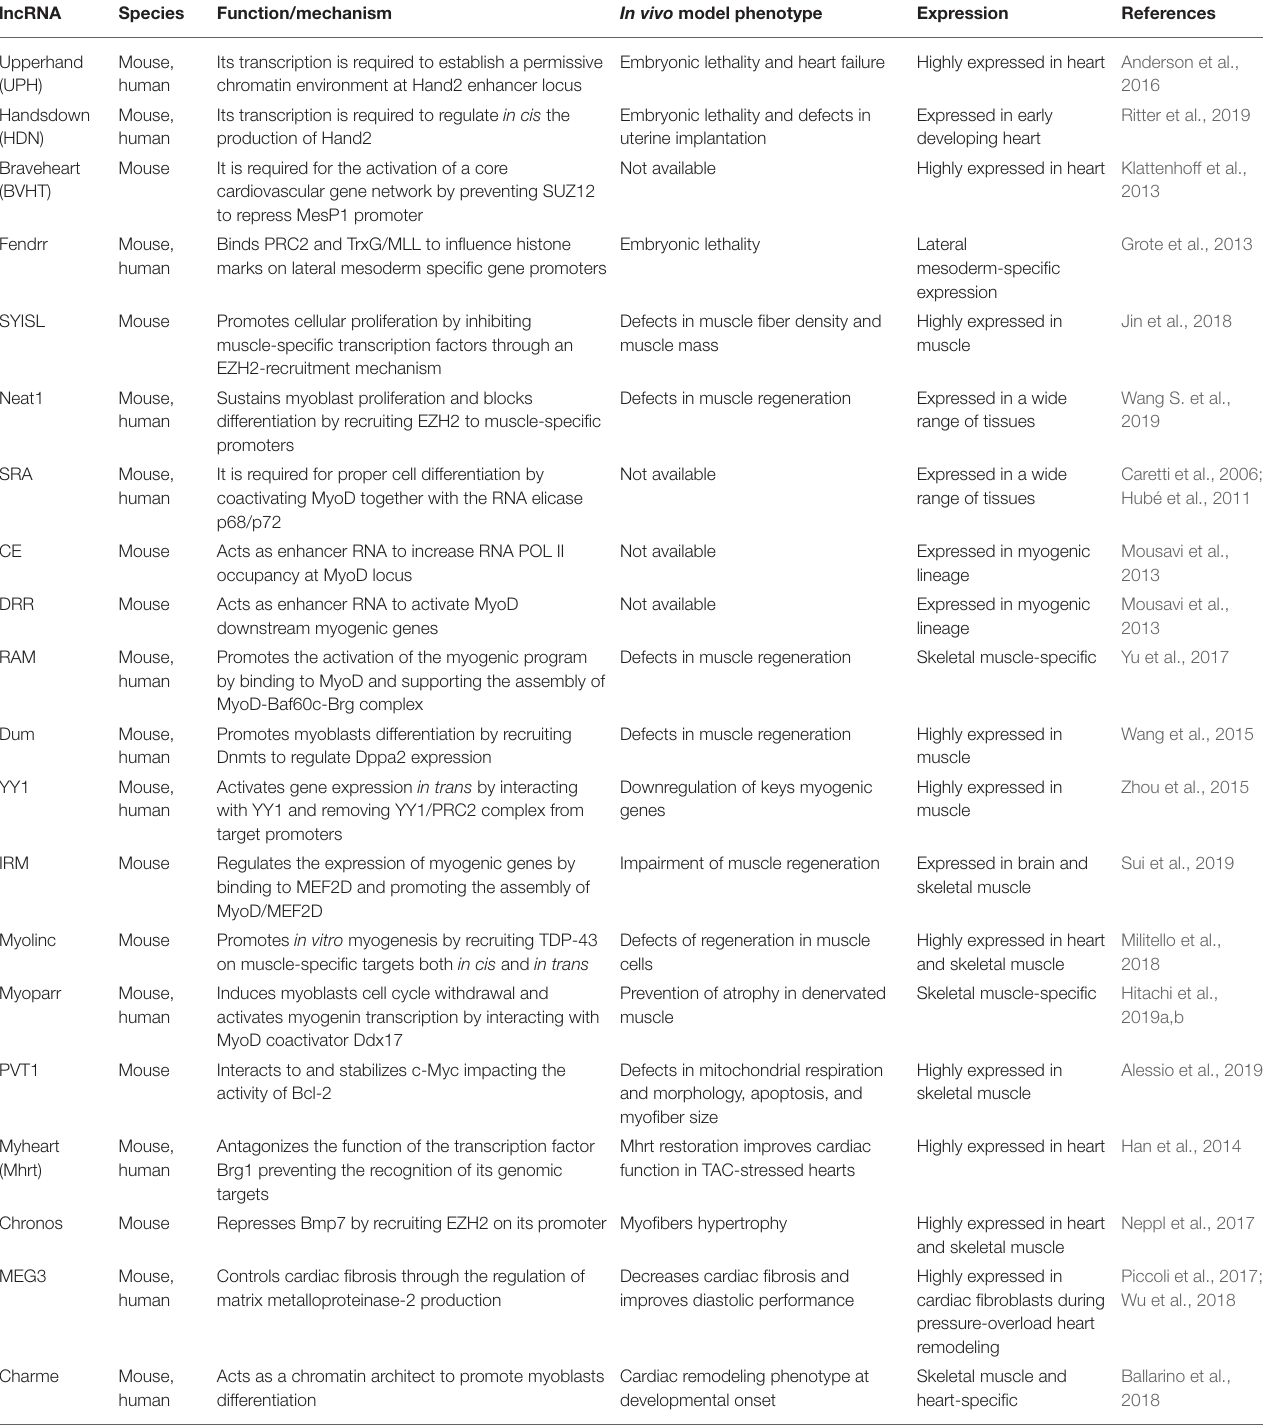
TABLE 1 | Nuclear long non-coding RNAs (lncRNAs) in skeletal and cardiac myogenesis.